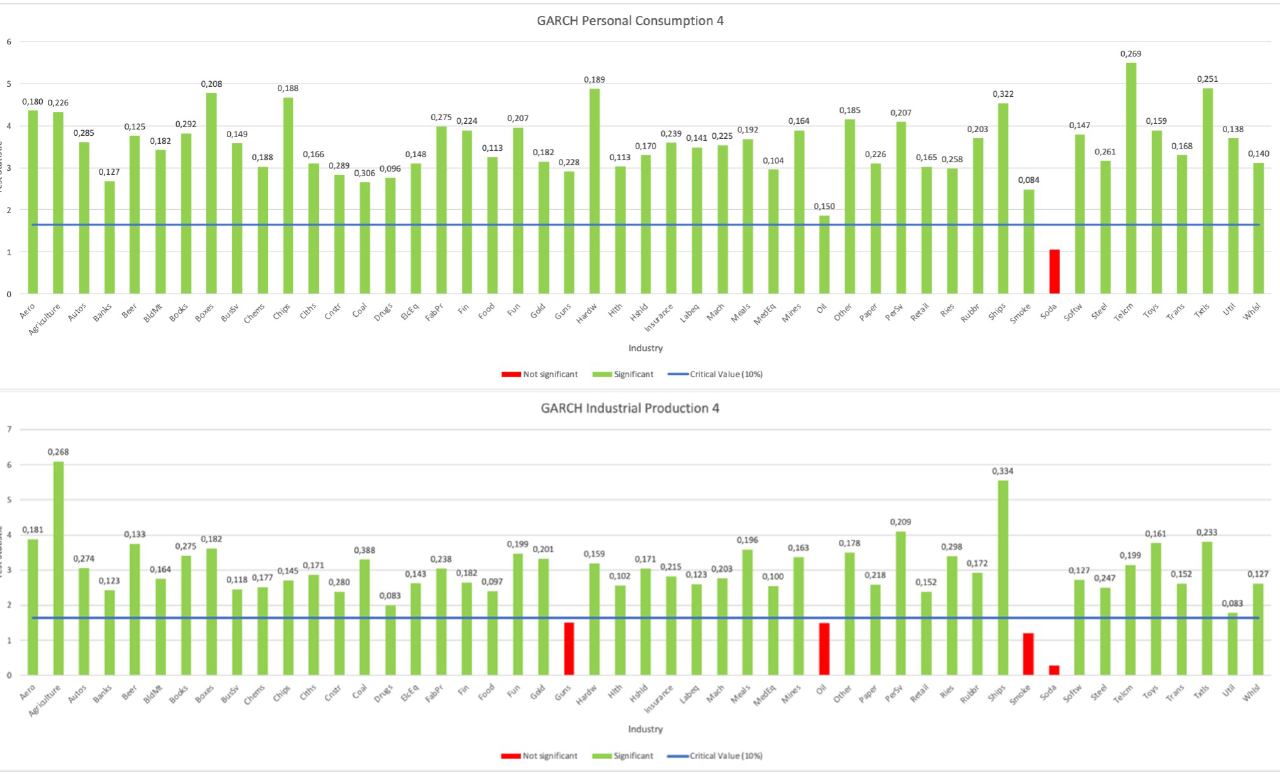
Figure 1. Visualisation of the impact of uncertainty in Personal Consumption and Industrial Produc- tion on the standard deviation of stock